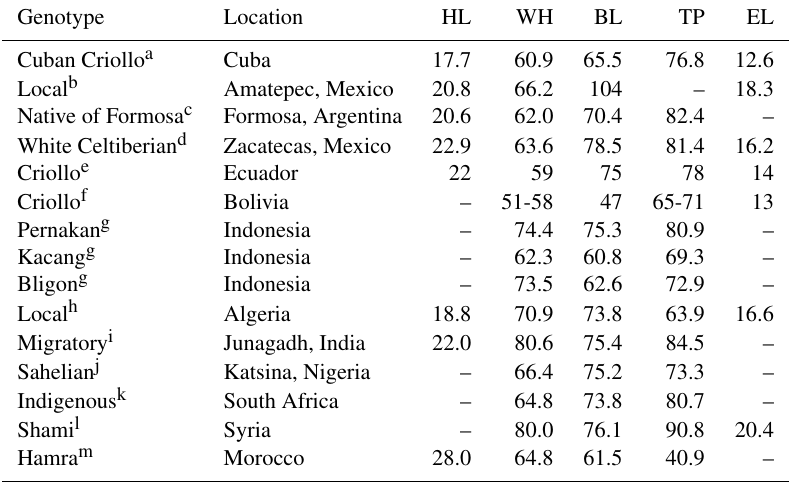
Table 2. Morphometric characteristics (mean ± SD, cm) of local goats in diverse regions of the world.